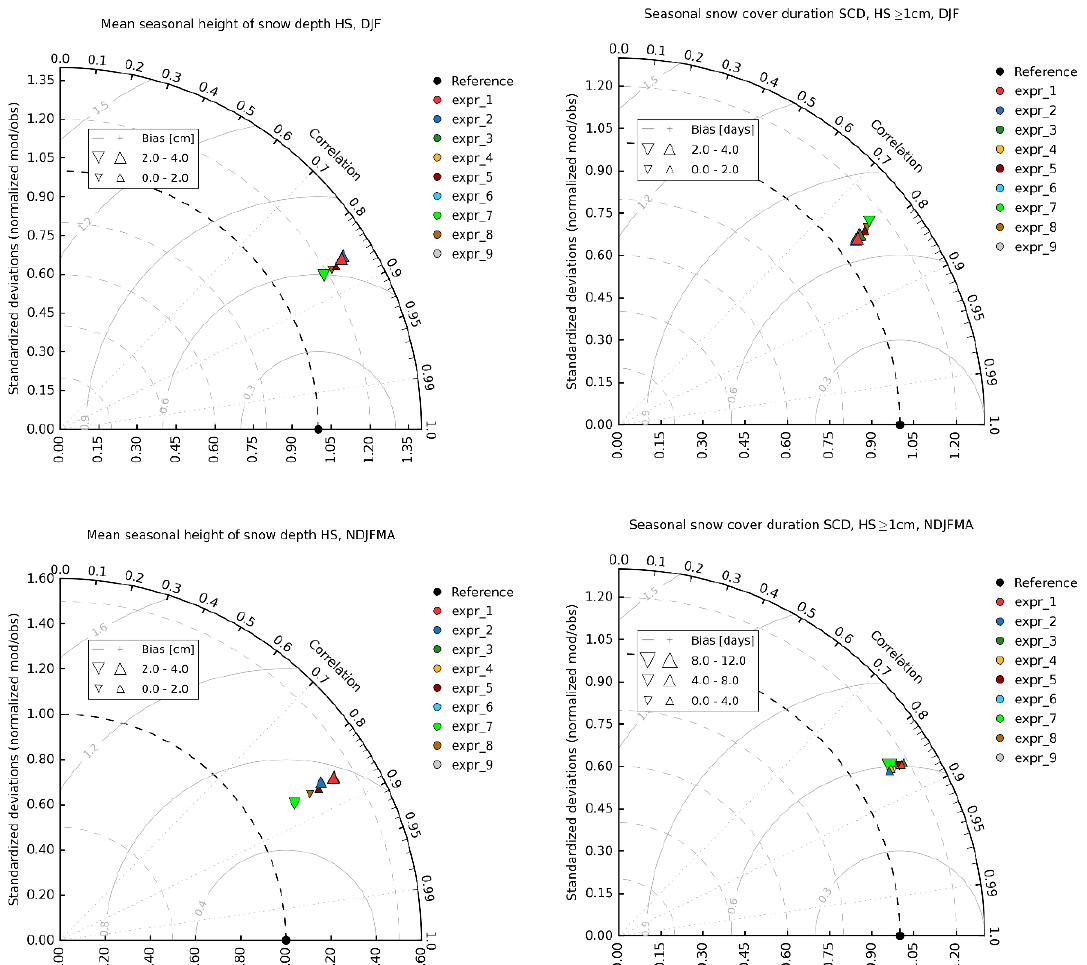
Figure 2. Taylor diagrams for seasonal snow depth (HS) ( left column ) and snow cover duration (SCD) (HS ≥ 1 cm, right column ) comparing station observations with SG-CL model simulations for the period covering the seasons of 1961 / 62 to 2017 / 18. The seasons considered are the core winter (December to February—DJF) ( top row ) and the extended season (November to April—NDJFMA) ( bottom row ). Number of stations is 85 covering an elevation range from 150 to 2500 m a.s.l. (see Figure 1).